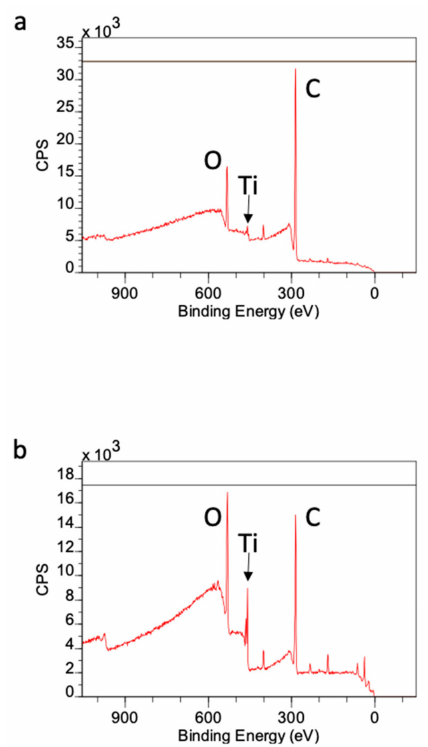
Figure 8. ( a ) XPS survey spectra of acid-etched Ti microfiber sca ff old. The intensity of carbon is prominent. ( b ) XPS surgery spectra of the UV-treated acid-etched Ti microfiber sca ff old. The intensities of oxygen and Ti is increased. O, oxygen; Ti, titanium; C,